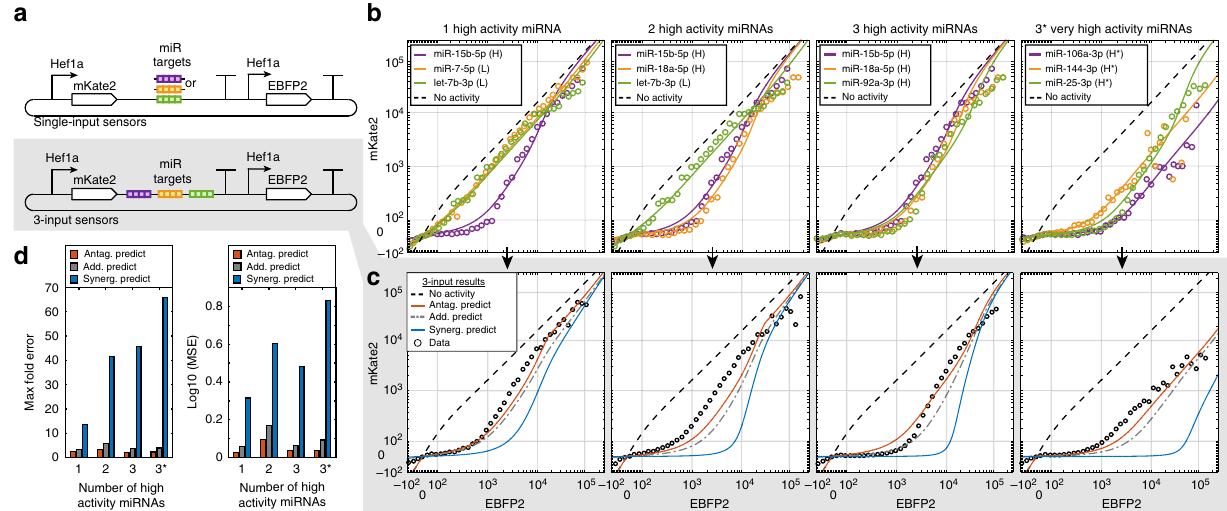
Fig. 3 Interactions between miRNA target site sets in the 3 ′ UTR sensors appear antagonistic. a Schematic for single-input sensors bearing one set of target sites (top) and 3-input sensors bearing three different sets of target sites (bottom) where all miRNA target sites are located in the 3 ′ UTR. b miRNA repression data and model fi ts for different single-input sensors. Plots are ordered by increasing number of high activity miRNA target site sets. miRNA activities are denoted as low (L), high (H), or very high (H*). c Comparison of predicted miRNA repression to data obtained for 3-input sensors. Predictions for 3-input sensors are computed based on M and K m parameters measured from single-input sensors. Using the assumption that miRNA target sites act antagonistically yields predictions (red) which are equivalent to taking the maximum activity (minimum mKate2 expression) of the three single-input sensors for each EBFP2 expression level. Additive predictions (gray dashed) are made using the Chou – Talalay method. Synergistic predictions are made by multiplying fold repression from each of the single-input sensors within each EBFP2 transfection bin. Predictions using the antagonistic or additive models are markedly better than those from a synergistic model, indicating that miRNA repression for multi-input sensors is not a simple multiplicative effect. While antagonistic and additive models were close in these examples, predictions can diverge drastically when several miRNA inputs are combined and when input activities are very similar. d Analysis of prediction errors for 3-input sensors. Errors are measured by computing the maximum fold difference between predictions and data across all bins of EBFP2 expression (max fold error) or by computing the mean squared error (MSE). For both metrics and for all tested combinations of low/high/very high (*) activity miRNAs, antagonistic interaction explains the data better than an additive or